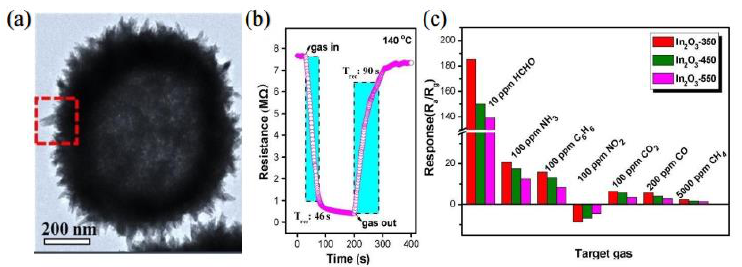
Figure 4. ( a ) TEM images of In 2 O 3 -350; ( b ) response transient of the In 2 O 3 -350 sensor to 1 ppm of HCHO; ( c ) the response values of the In 2 O 3 -350 sensor to different gases at 140 °C [50].